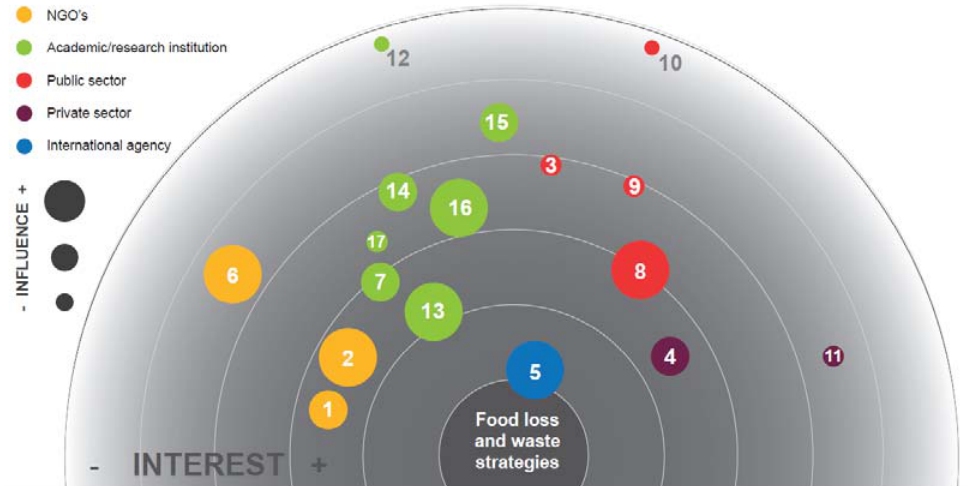
Figure 1. Stakeholder analysis for members of the CR-FLW network. 1. Alimentalistas, 2. Food Bank, 3. Education and